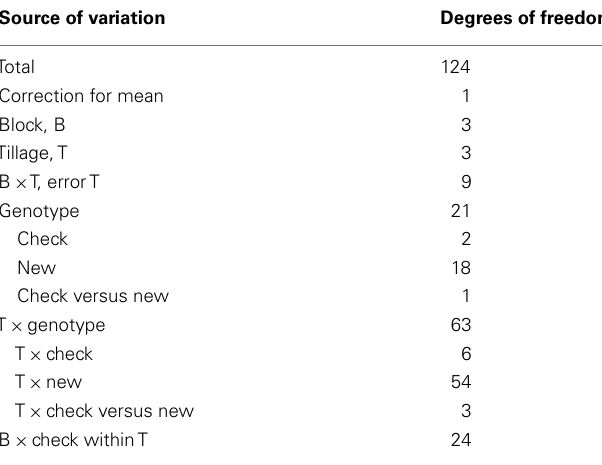
design. The date experimental units are distributed across all the genotype entries in a